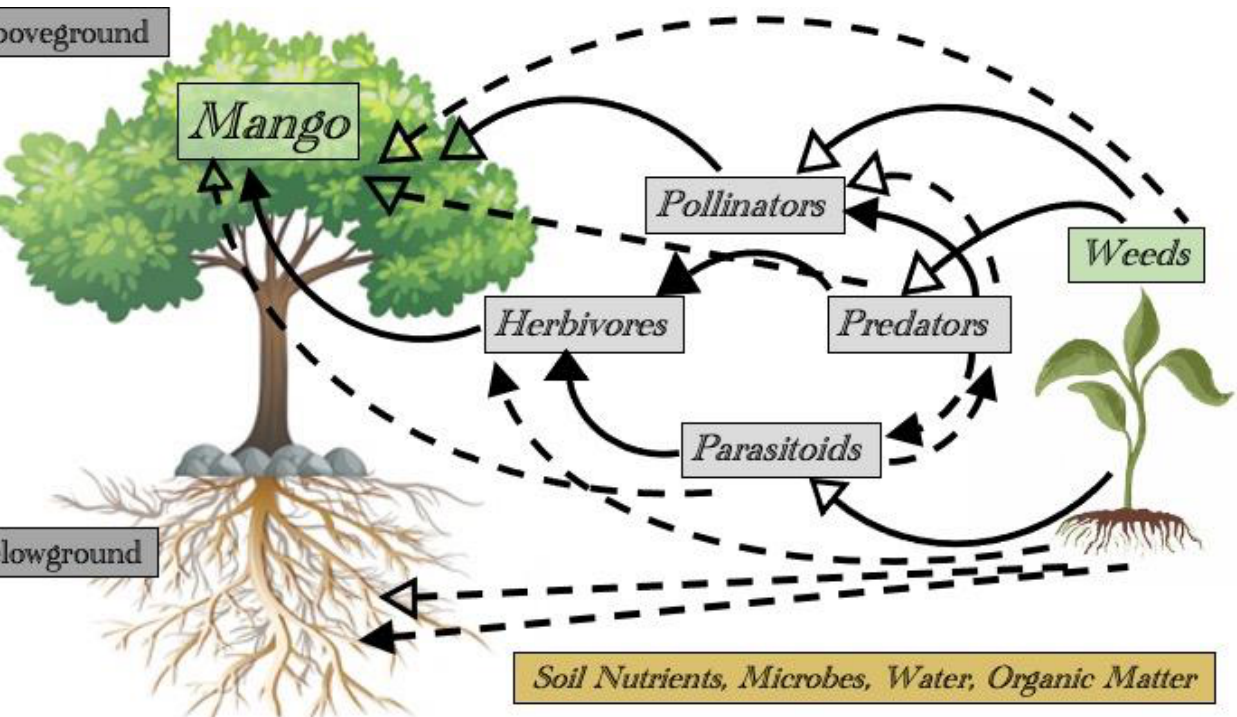
Figure 1. Potential interactions between weeds and mango trees, above and belowground. Direct interactions (solid line) and indirect interactions (dashed line); positive effects (open arrowhead), negative effects (solid arrowhead).